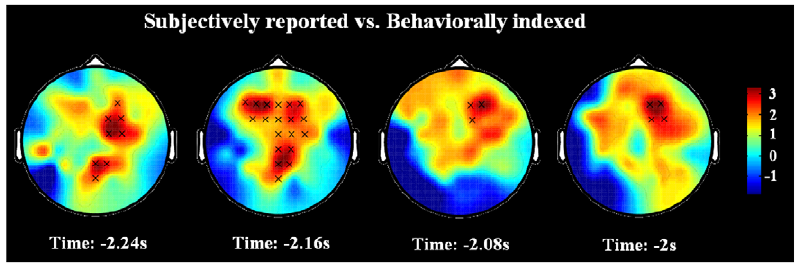
Figure 2. Topographical distributions of the enhanced gamma band activity associated with subjectively reported mind wandering relative to behavioral indexed mind wandering. The values are the statistical results of the differences. The ‘X’ marks the significant clusters of electrodes in the topographies.